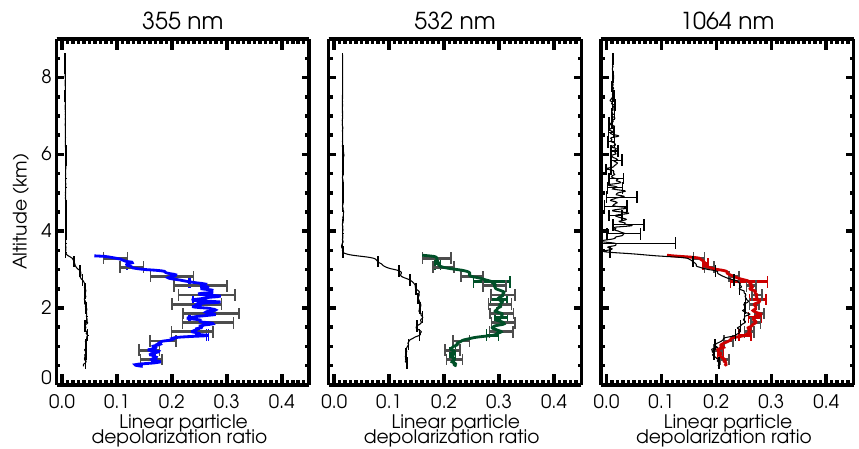
Figure 5. Line plots illustrating the volume and linear particle depolarization ratio profile for the HSRL-2 measurements at 17:12UT (17.2UT) on 13 July 2014. The volume depolarization ratio is shown as a thin black line. The error bars on the volume depolarization ratio represent random error (most are small and mostly obscured except 1064nm). The particle depolarization ratio is shown as a thick colored line. Colored error bars indicate random error (most are small enough to be obscured by the line) while gray error bars indicate systematic uncertainty, estimated as described in the text. Systematic uncertainty is not shown for the volume depolarization ratio; see text for estimate. The vertical resolution of these measurements is 30m and the horizontal resolution is 10s for all wavelengths.